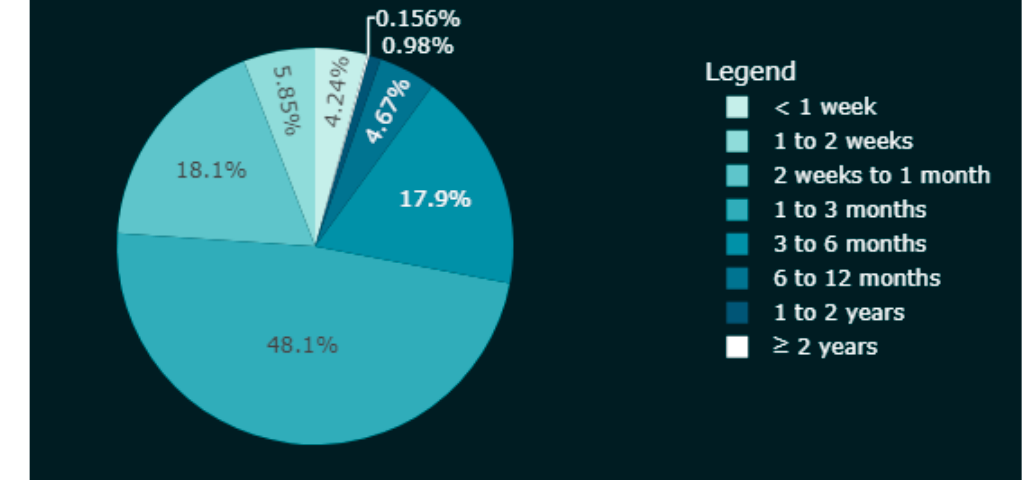
Figure 38. Distribution of DA assessment time (2004–2022).